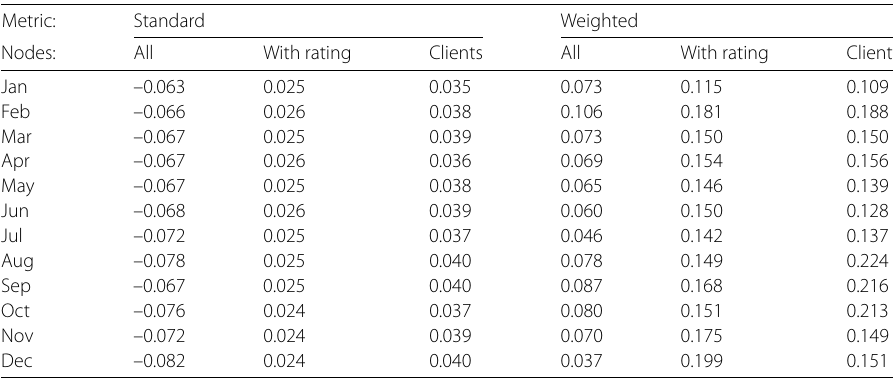
Table 11 Assortativity coefficient for risk rating. The columns with rating refers to the subgraph of nodes with known rating. The columns customers refers to the subgraph of nodes with customer status yes . In the last two columns, the metric for assortativity is modified in order to take into account weights, specifically e ij is computed as the fraction of volume, not the number of edges (see main text for more